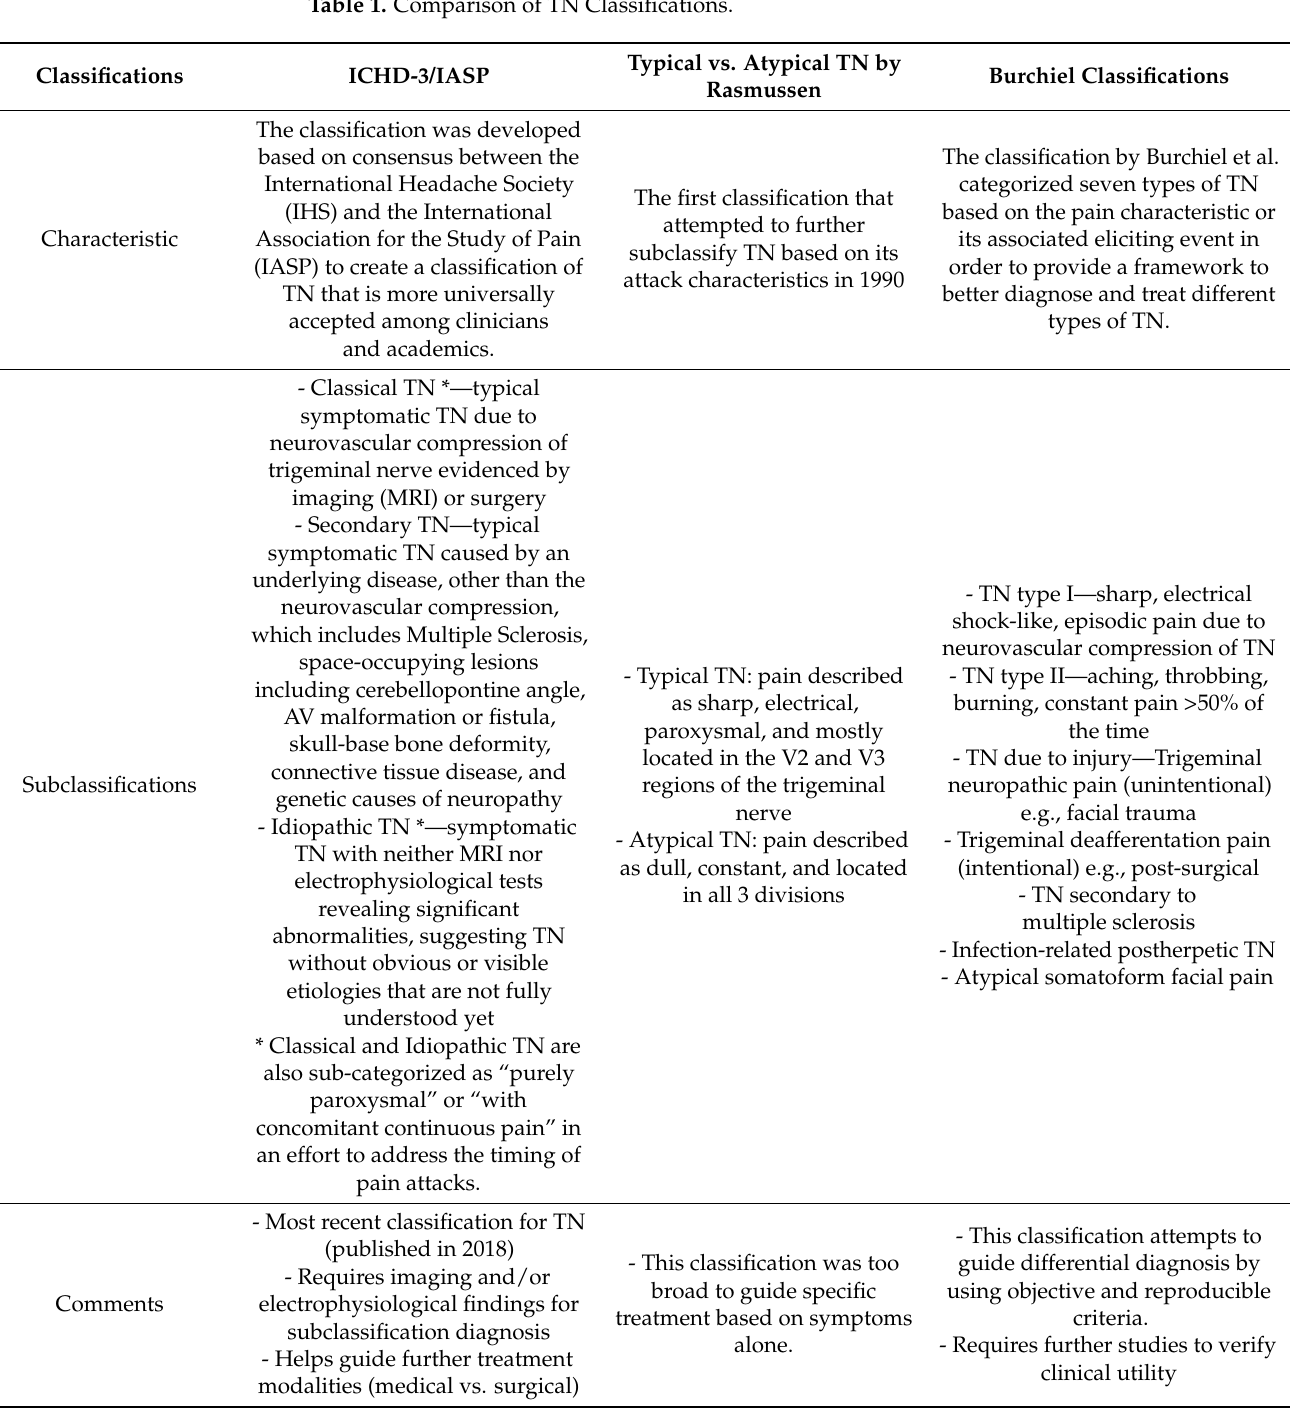
Table 1. Comparison of TN